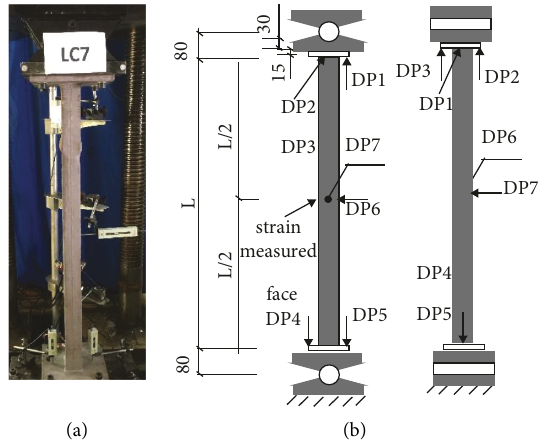
Figure 1: Test loading device. (a) Field loading; (b) schematic of loading device.